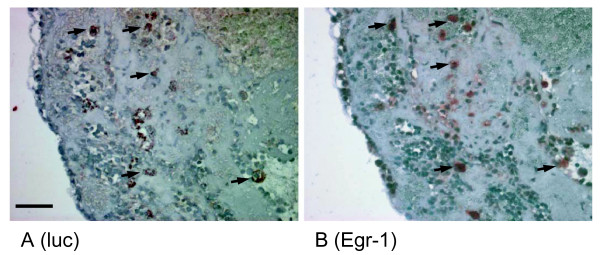
Immunohistochemical analyses of Egr-1 driven luciferase expression in regenerating liver. Egr-1-luc mice 4-8 weeks of age were subjected to one third liver hepatectomy as described in "Methods". Forty-eight hours after surgery mice were sacrificed, liver tissue fixed in PFA and stained for luciferase (luc). Tissue next to the site of surgery (rim upper left corner in both images) is shown and cells staining positive for luciferase (A) as well as Egr-1 (B) appear as clusters with brown-reddish staining (arrows; scale bar: 50 μm)